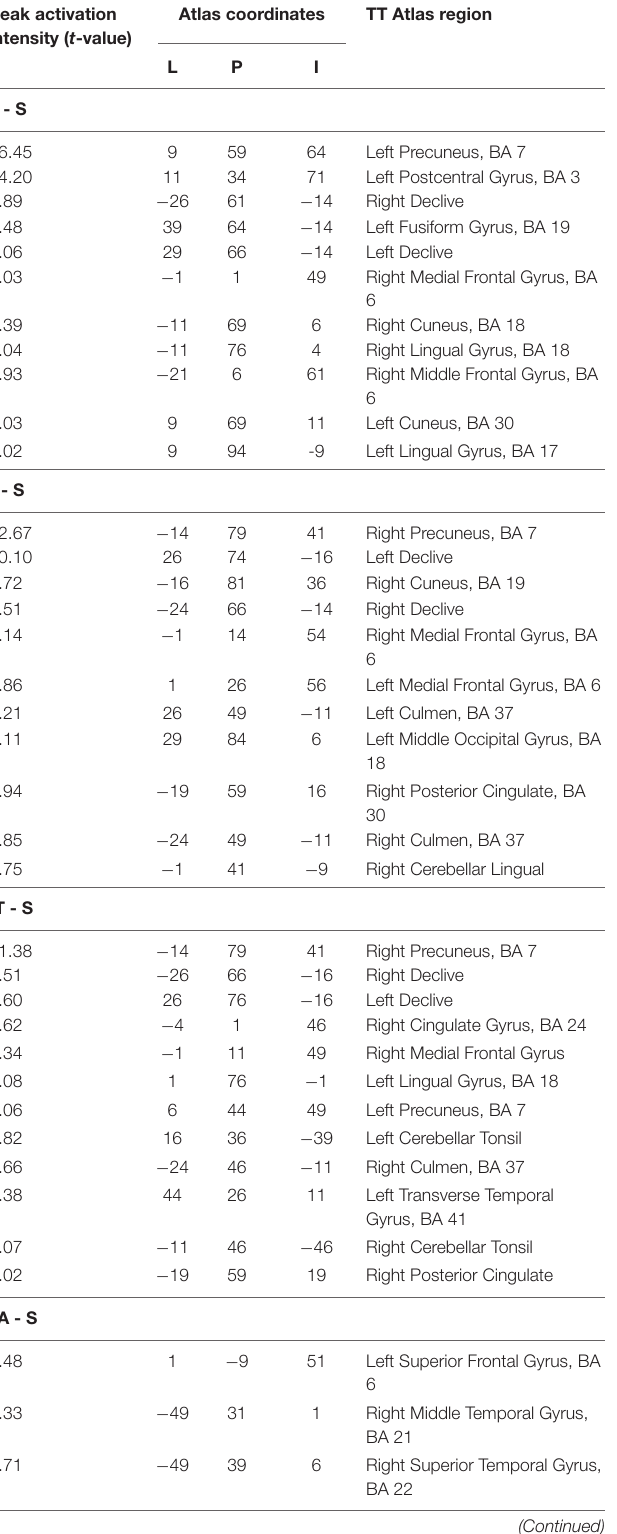
TABLE 2 | Peak activation ( t -value), spatial coordinates (Left, Posterior, Inferior) and brain region of statistically significant brain activity with respect to the Talairach and Tournoux (TT) brain atlas.